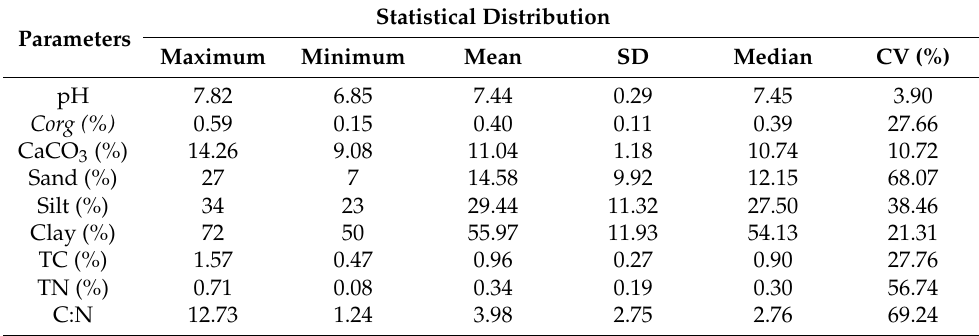
Table 1. Descriptive statistics of the sediment geochemical